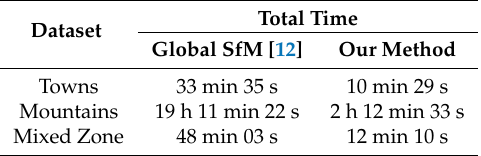
Table 5. The processing time for experimental comparison